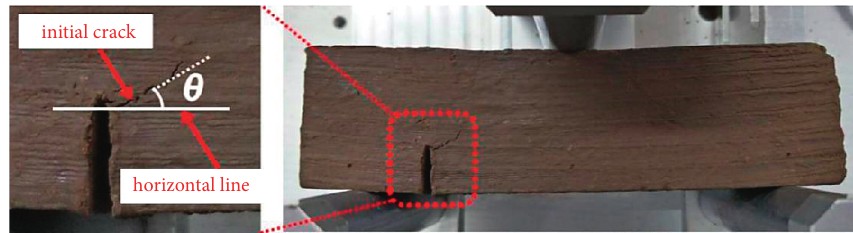
Figure 7: The initial crack angle θ with the offset ratio C ≠ 0.